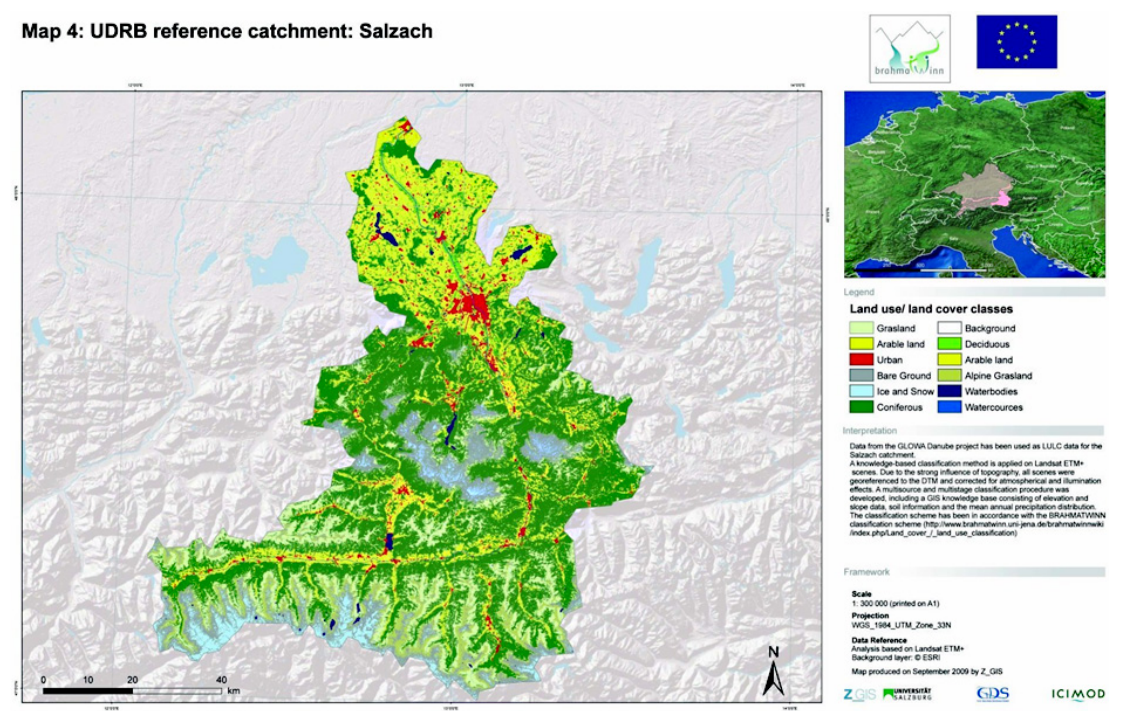
Figure 8. Land use / land cover classification for the Salzach river basin (Austria /